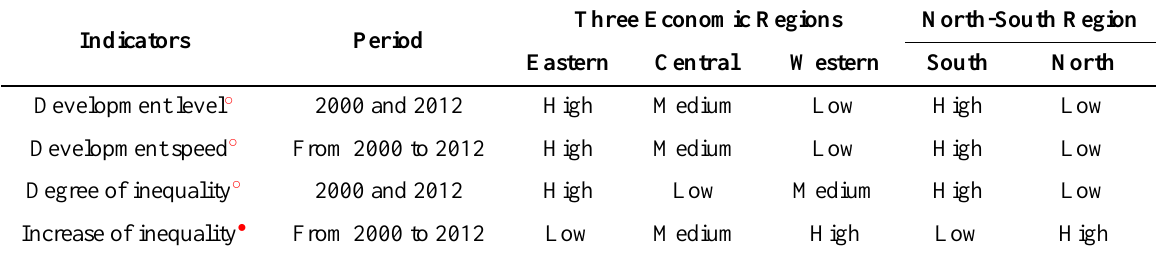
Table 5. The development level and inequality of internal eastern-central-western region and north-south region from 2000 to 2012. Three Economic Regions North-South Region Indicators Period Eastern Central Western South North Development level ○ 2000 and 2012 High Medium Low High Low Development speed ○ From 2000 to 2012 High Medium Low High Low Degree of inequality ○ 2000 and 2012 High Low Medium High Low Increase of inequality ● From 2000 to 2012 Low Medium High Low